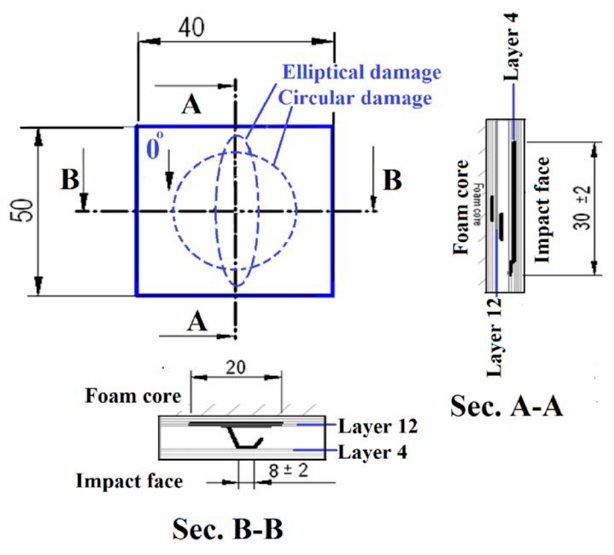
Figure 4. Sectional view of core specimen